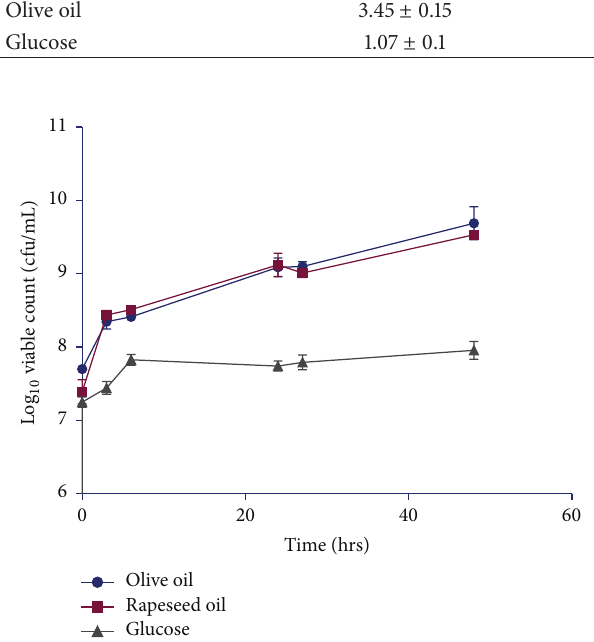
Figure 1: Growth analysis of the shake flask culture of R. eutropha NCMBI 10442 grown in BSM at 30 ∘ C and 150rpm using rapeseed oil, olive oil, and glucose as sources of carbon for the production of PHB. Results are an average of